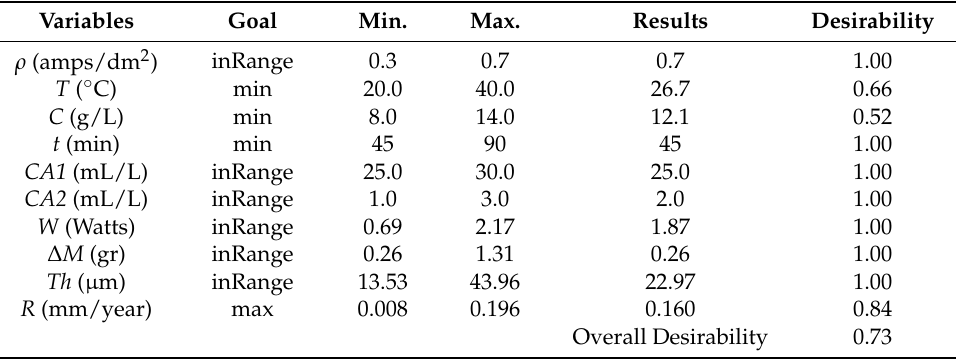
Table 14. The fifth criterion that was considered: maximizing the resistance ( R ) and minimizing the temperature ( T ), the concentration ( C ), and the time ( t ). Variables Goal Min. Max. Results